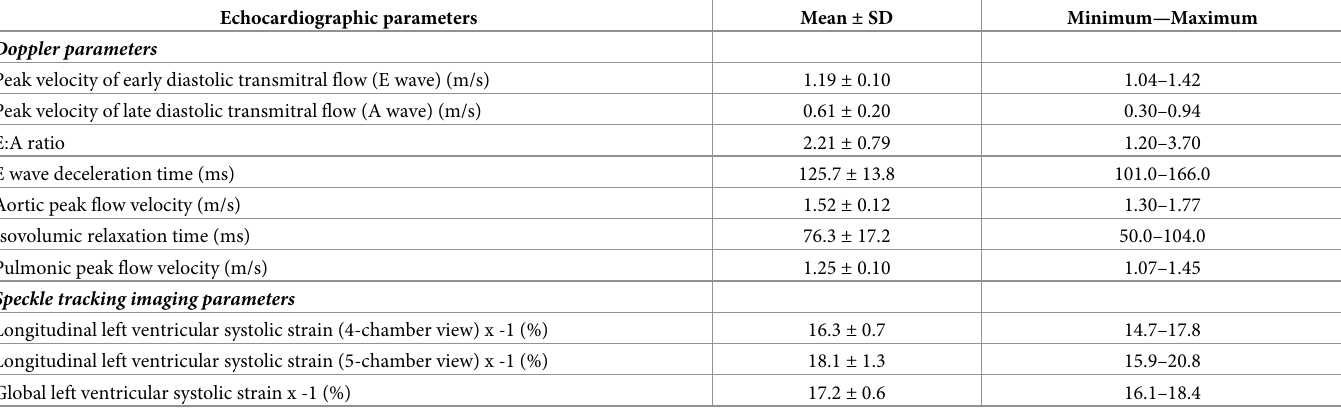
Table 2. Mean ± standard deviation (SD), minimum and maximum values of repeated measurements of Doppler (n = 7) and STE (n = 3) variables (n = 10) obtained by a trained observer in 4 Borneo orangutans ( Pongo pygmaeus pygmaeus ) from 96 transthoracic examinations. Echocardiographic parameters